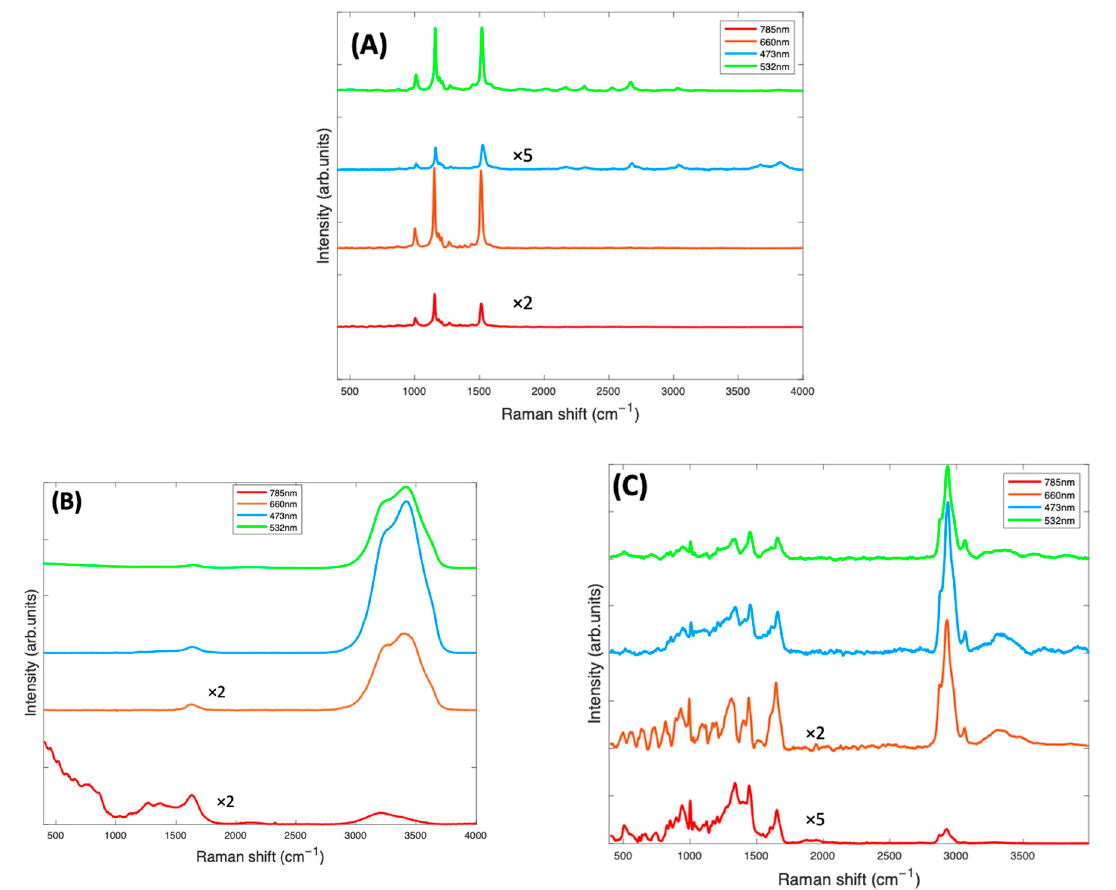
Figure 2. ( A ): Raman spectra at 4 different source laser wavelengths of Beta Carotene reference (Beta Carotene paste) taken with a ×60 objective and spectra of other components of the background contained in the Beta Carotene/BSA complex consisting of water ( B ) and BSA ( C ), both taken with a ×10 objective. The spectra have been offset by a constant factor for clarity.